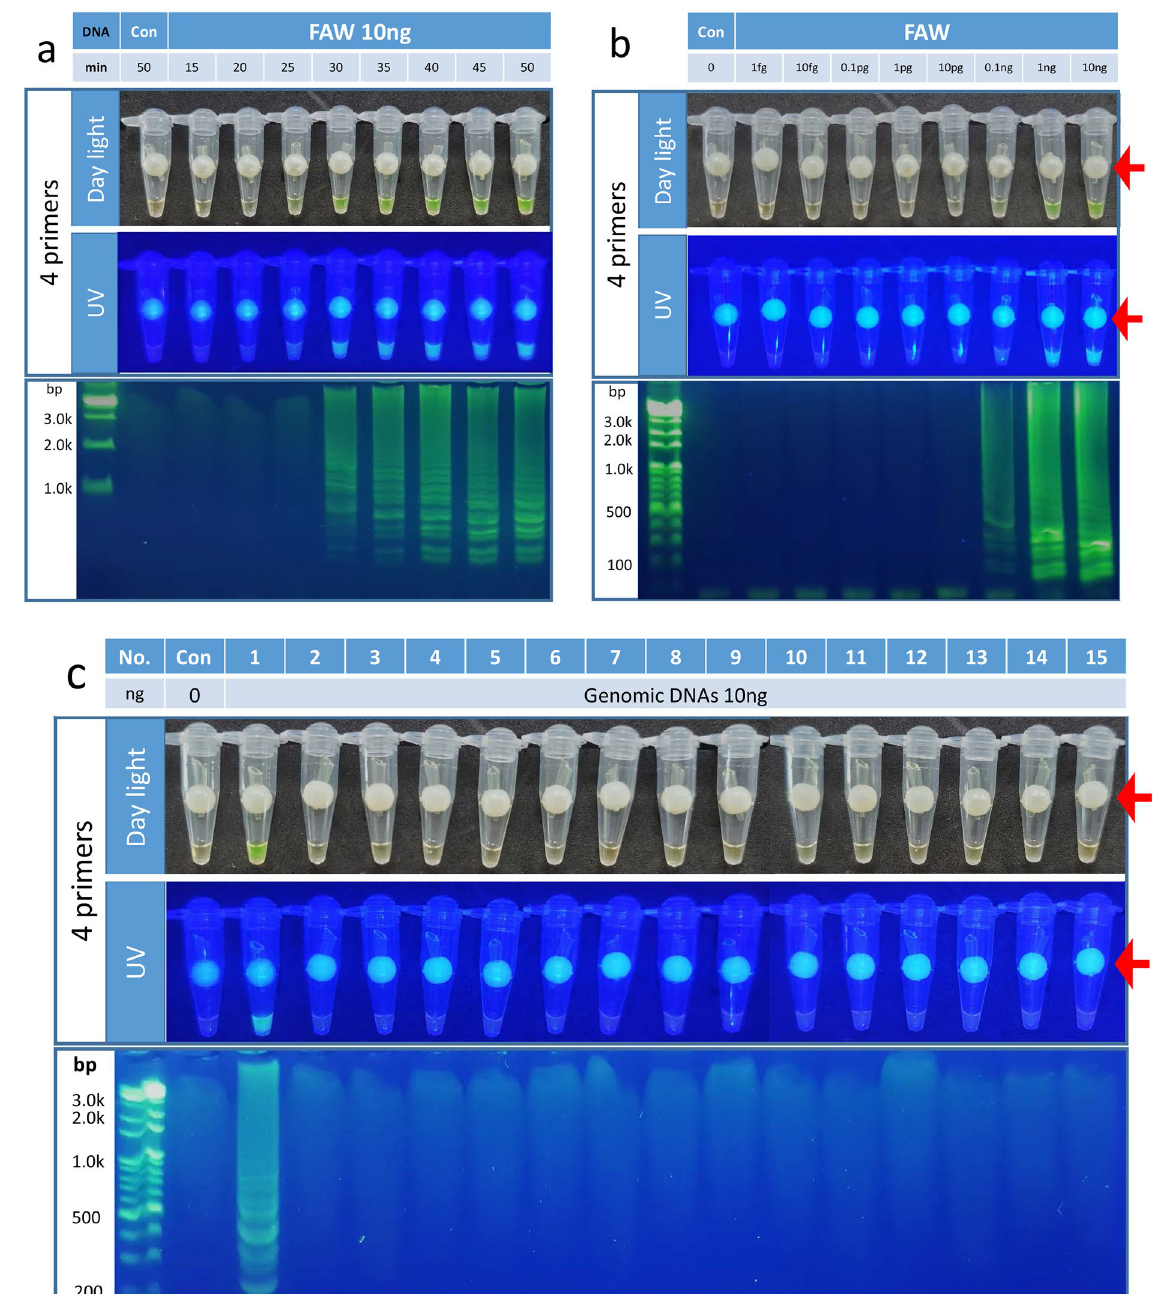
Figure 2. The optimum incubation periods, detection limits and FAW species specificities for the Sf4p LAMP assay. ( a ) After 35 min incubation, the fluorescence signals and the patterns of ladder-shaped DNA fragments were similar among Sf4p LAMP assays. No amplification was detected after 50 min of incubation when genomic DNA was not added (Control = Con). ( b ) When serially diluted FAW genomic DNAs were used to determine detection limits for the Sf40 LAMP assay, fluorescence signals and DNA amplification were detected above 0.1 ng/µl of FWA genomic DNA. The fluorescence intensities and patterns of DNA fragments were similar above 1 ng/µl of FAW genomic DNA. ( c ) When genomic DNAs of moths captured by FAW sex-pheromone traps (1–10) or raised in the insectarium (11–15) were used for the Sf4p LAMP assay, strong fluorescence signals and amplified DNA fragments were observed from FAW genomic DNA. Moth species used in this study were as follows: 1. FAW, 2. Axylia putris , 3. Mythimna loreyi, 4. Discestra trifolii , 5. Hermonassa cecilia , 6. Anomis flava , 7. Aedia leucomelas , 8. Pleuroptya ruralis , 9. Mythimna separata , 10. Lacanobia contigua , 11. Helicoverpa armigera, 12. Mamestra brassicae , 13. Spodoptera exigua , 14. Spodoptera litura , 15. Plutella xylostella . The red arrows indicate the contamination-free SYBR green delivery